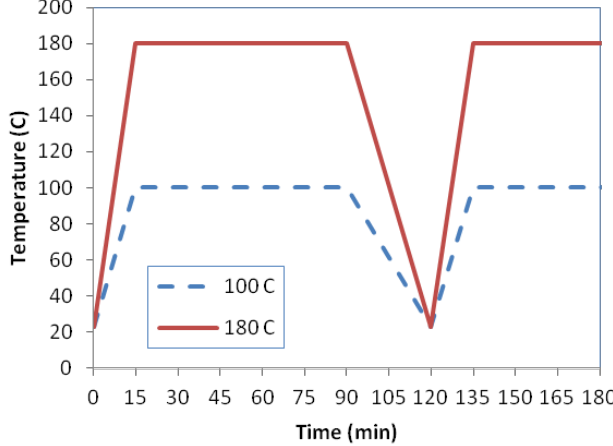
Figure 2. Temperature and humidity regime (2-h cycles).